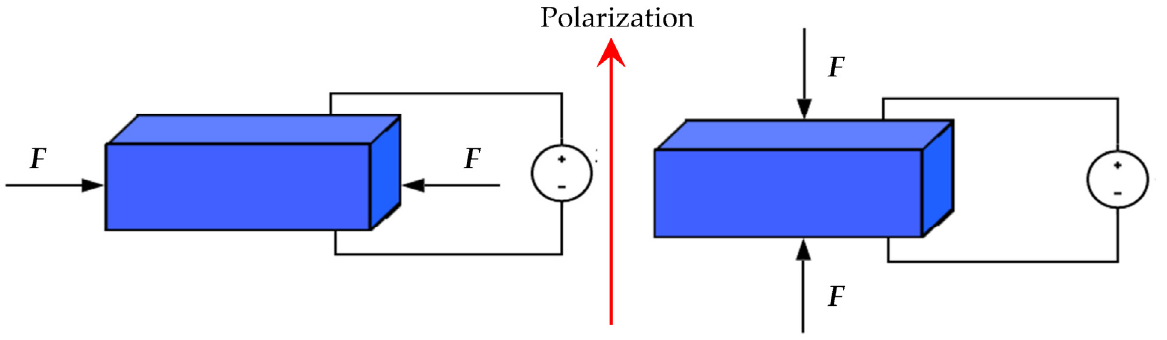
Figure 9. Models of a piezoelectric material [175].